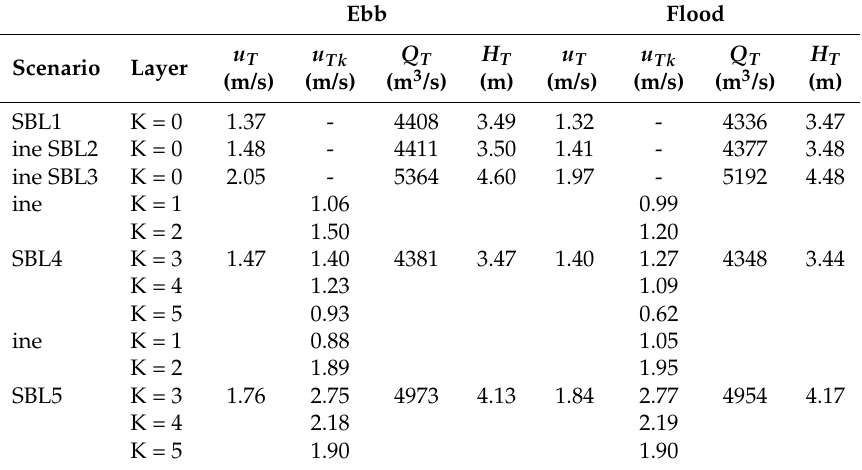
Table 3. Peak flow velocity ( u t ) and instantaneous discharge ( Q T ) just downstream of the turbine exit for a typical spring tidal cycle during flood and ebb power generation, and the corresponding head difference ( H T ) . Velocities for cases SBL4 and SBL5 are presented both with a depth-averaged value ( u ) and with separate values for respective computational layers ( u T